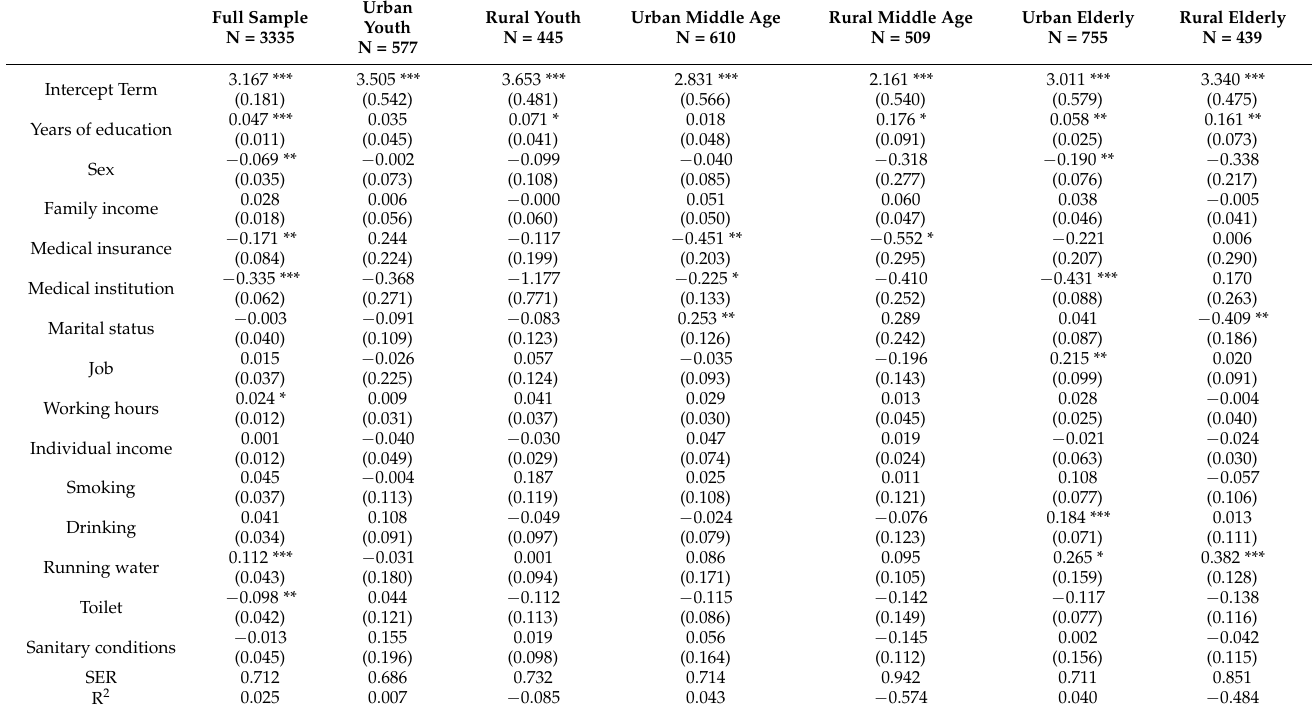
Table A9. Results of two-stage least squares (by age and residence, for physical